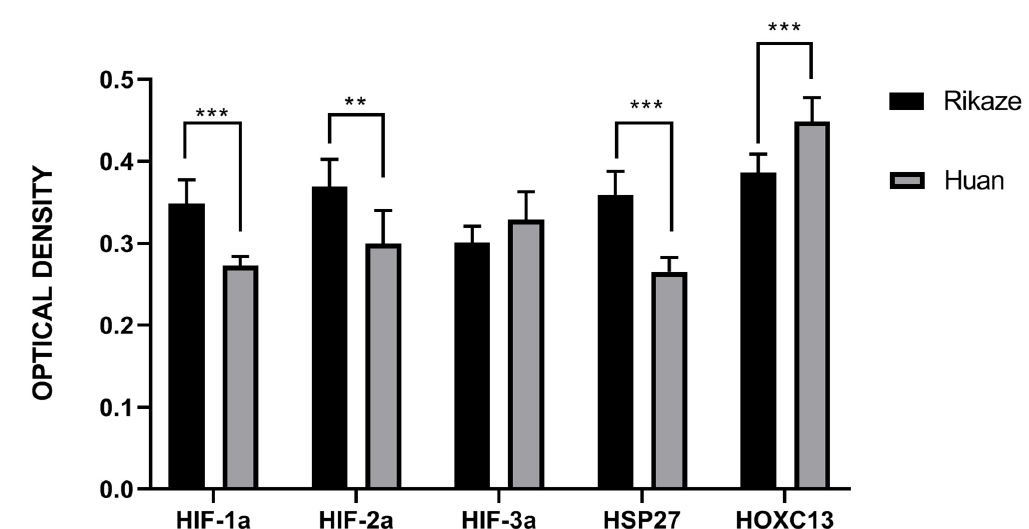
Figure 6. Total immunostaining of HIF-1a, HIF-2a, HIF-3a, HSP27, and Hoxc13 in the secondary hair follicles of Tibetan cashmere goat. Rikaze indicates that the goat was from Rikaze Province while Huan indicates the goat was from Huan County. ** Indicates a significant difference in which the p -value was between 0.01 and 0.05 while *** indicates a significant difference with a p -value < 0.01.